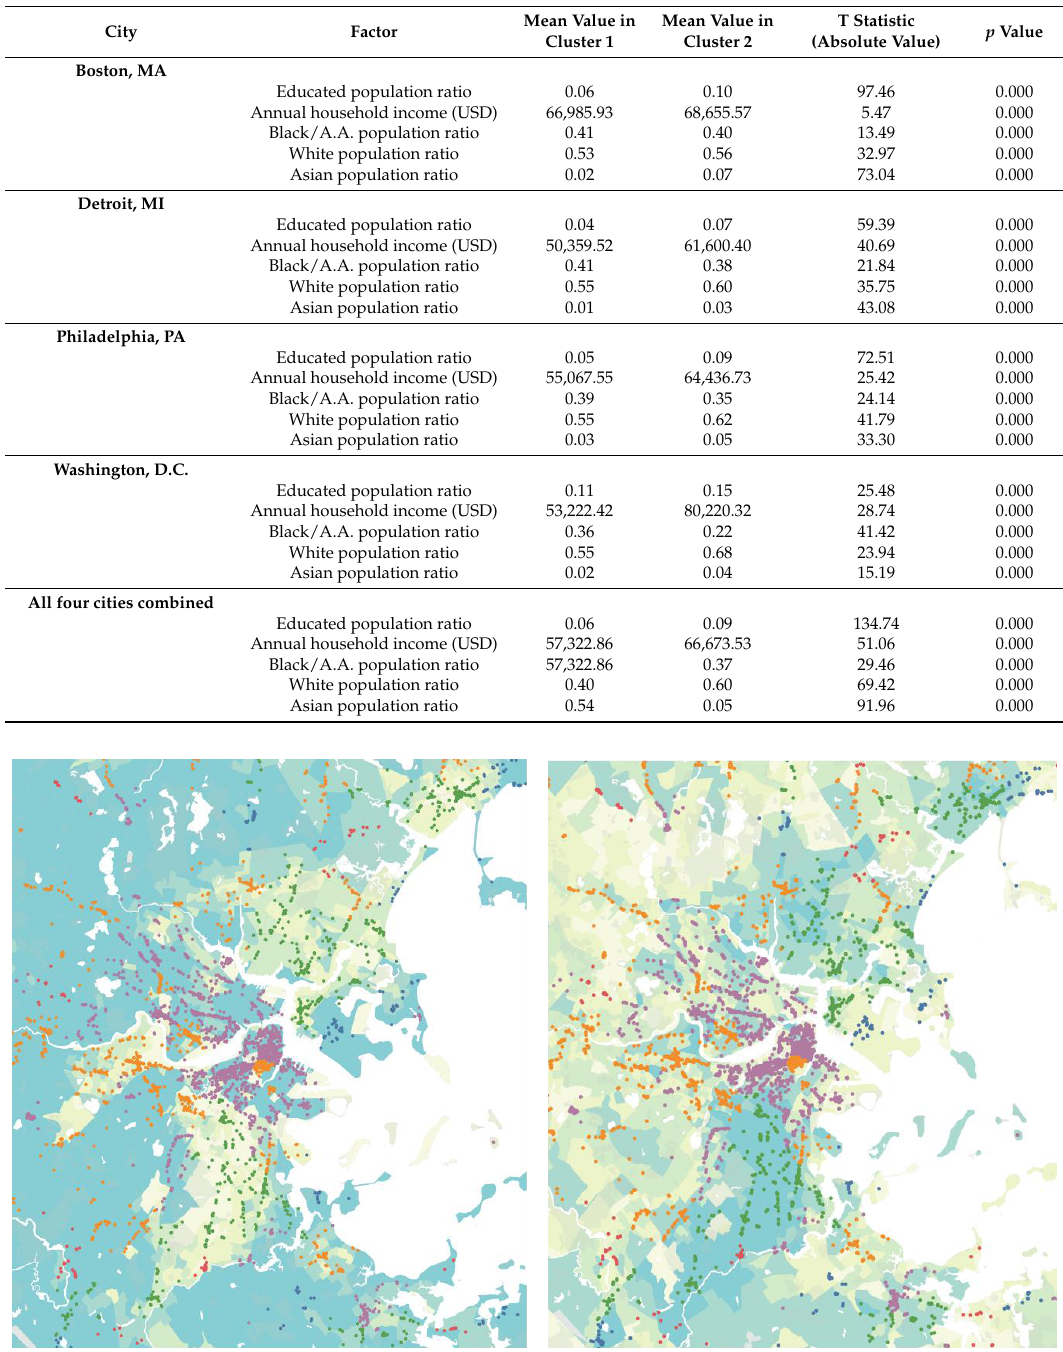
Table 6. t -Test results between the two clusters for demographic variables.